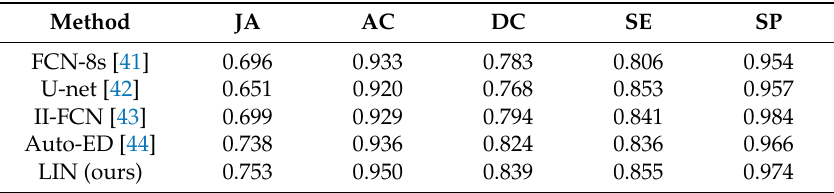
Table 8. Lesion segmentation performances of different frameworks.